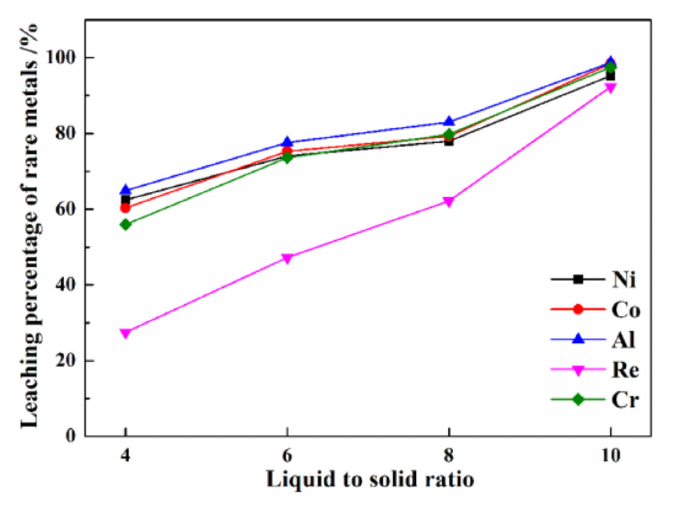
Figure 6. The leaching percentages of rare metals under various liquid–solid